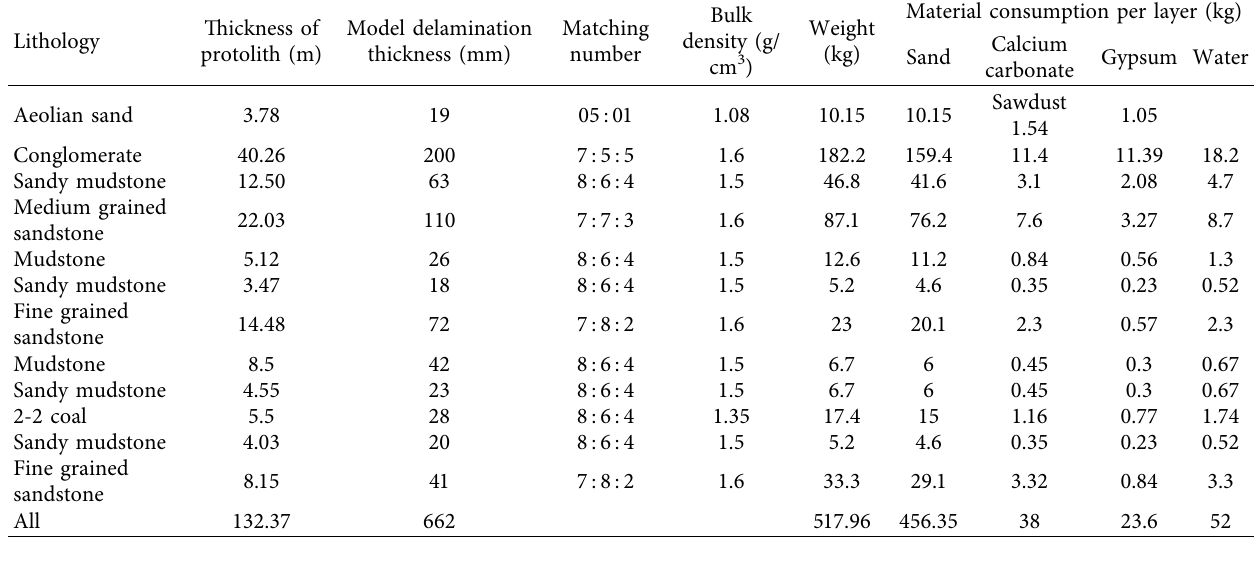
Table 3: Material ratio of the model rock layer.